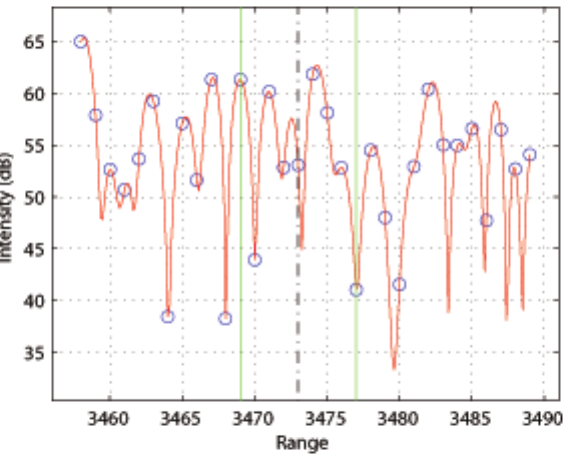
Figure 4. Corner reflector VH response (in